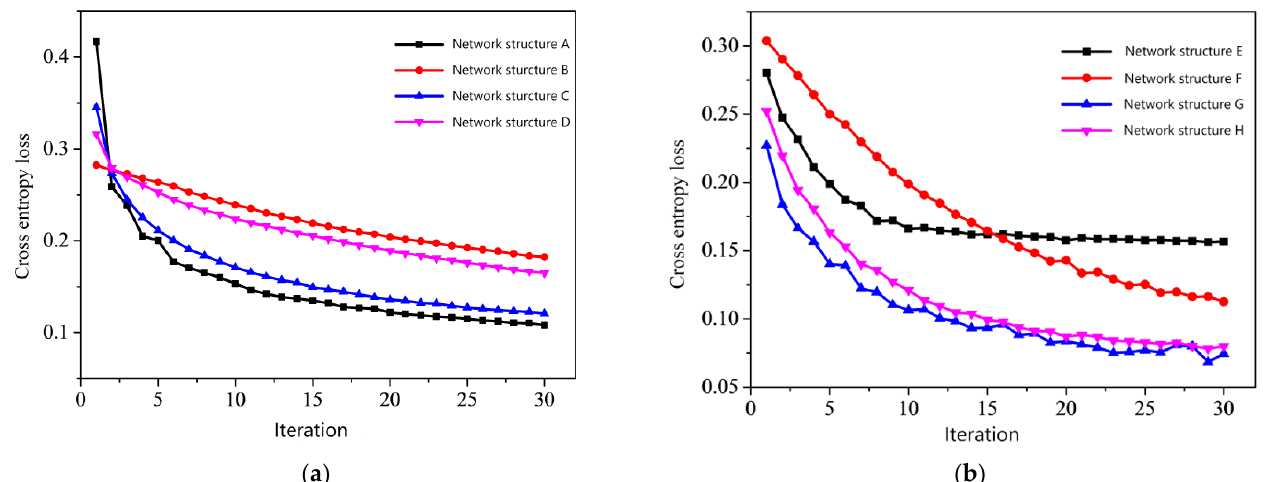
Figure 7. Change of cross entropy loss in the fault diagnosis of each network. ( a ) Shows the structures A, B, C and D, ( b ) Shows the structures E, F, G, and H. After training each network 30 times, the training effect was tested on the test set.